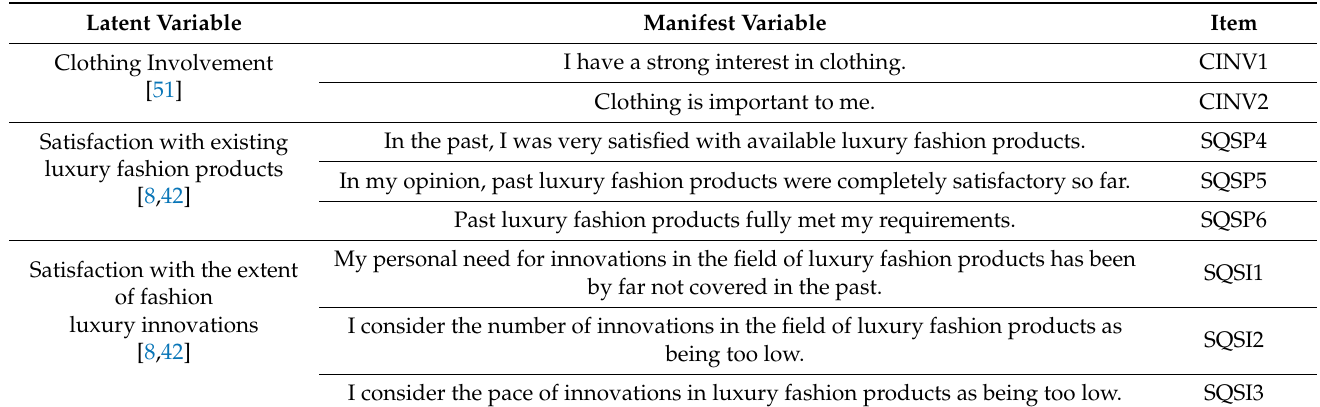
Table 3. The components of latent variable predictors: clothing involvement and status quo. Latent Variable